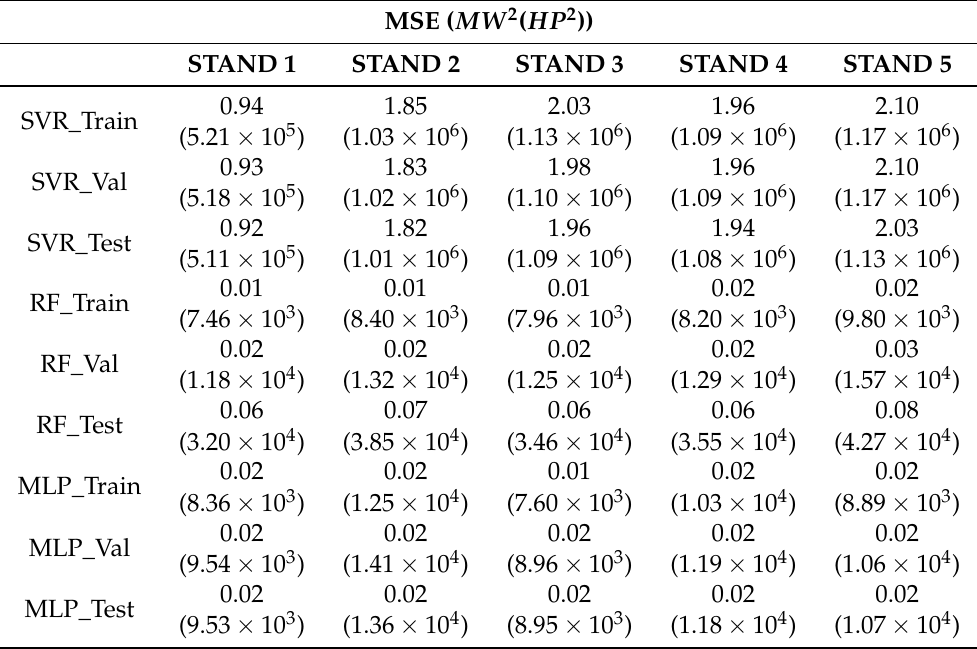
Table 19. Comparison with a baseline of machine learning methodologies for motor load prediction using